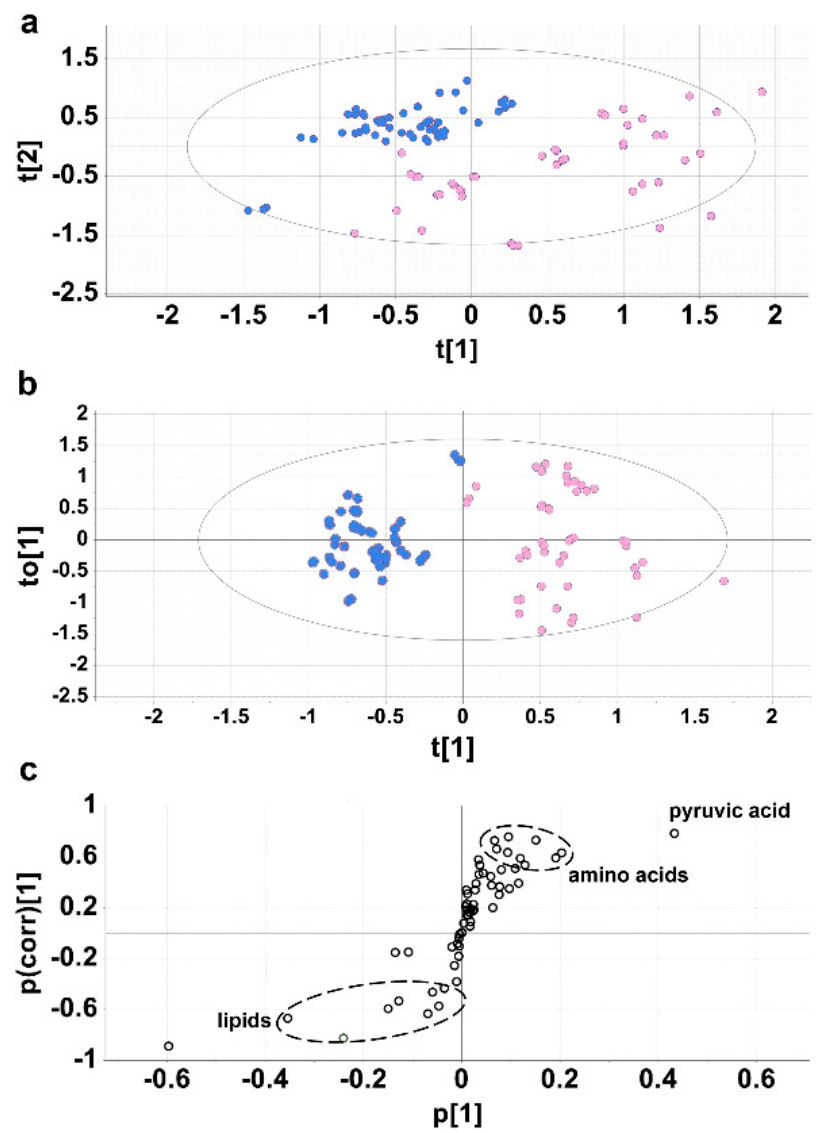
Figure 2. Multivariate data analysis of ascites metabolites vs. paired plasma metabolites. ( a ) Unsupervised PCA scores plot showing partial separation of cirrhotic ascites fluid (blue) and plasma samples (pink) from the same patients. Each point represents a sample analyzed by GC-MS. ( b ) Supervised OPLS-DA scores plot showing clustering and separation of cirrhotic ascites fluid and plasma samples. ( c ) OPLS-DA loadings S-plot showing metabolites upregulated in ascites fluid (top right) and metabolites downregulated in ascites samples relative to paired plasma samples (bottom left).